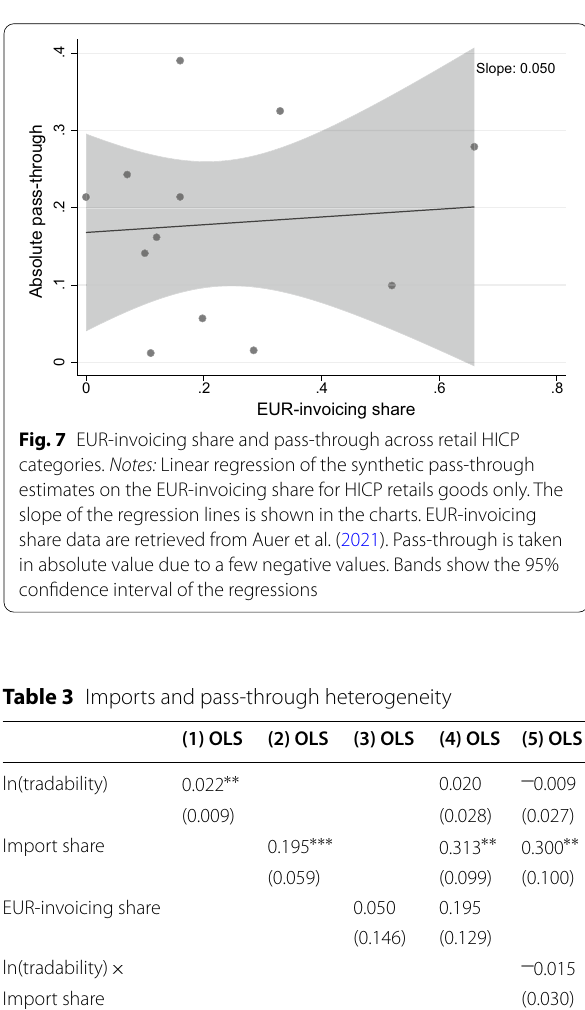
Linear regressions of the absolute pass-through on international tradability and the import share, with robust standard errors. Tradability is taken in log due to its exponential scale. Tradability data is taken from the BLS estimates of Johnson (2017), the import shares data from the SFSO, and the EUR-invoicing share for retail goods from Auer et al. (2022). Not all product categories can be matched, so the number of observations is lower than 85. p ∗ <0.1; p ∗∗ <0.05; p ∗∗∗ <0.01